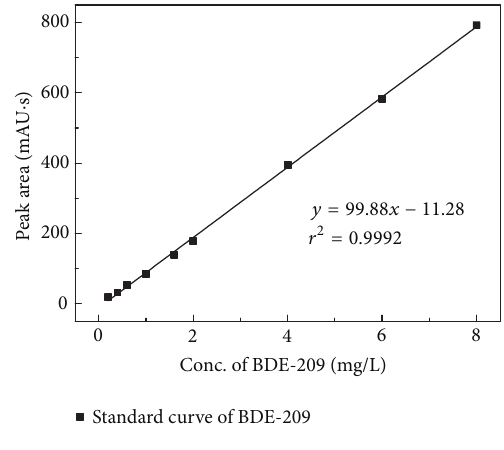
Figure 3: Standard curve of